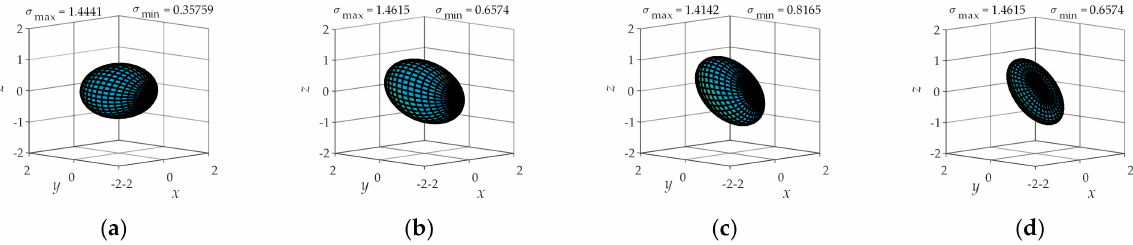
Figure 18. Manipulability ellipsoid of 2 P a 1 P 3 R a in the sagittal plane. ( a ) β = 30 ◦ ; ( b ) β = 60 ◦ ; ( c ) β = 90 ◦ ; ( d ) β = 120 ◦ .